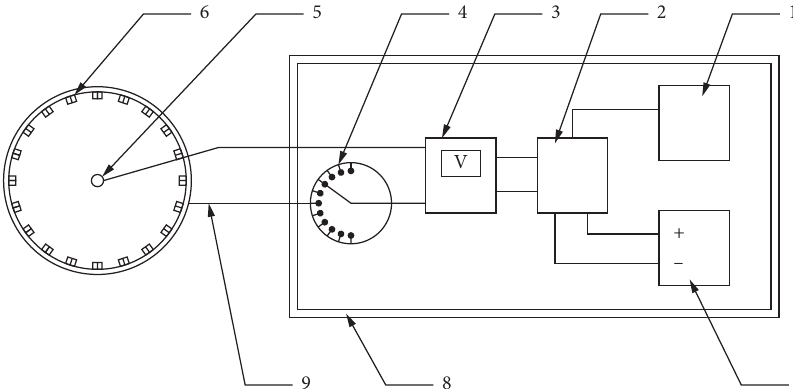
Figure 6: Schematic diagram of assembly structure principle of invention device (from [24]. 1-Data Storge, 2- General control device, 3- potentiometer, 4- transverter, 5- reference electrode, 6- under test sample, 7-battery, 8- pressure hull, 9-pressure resistant multicore